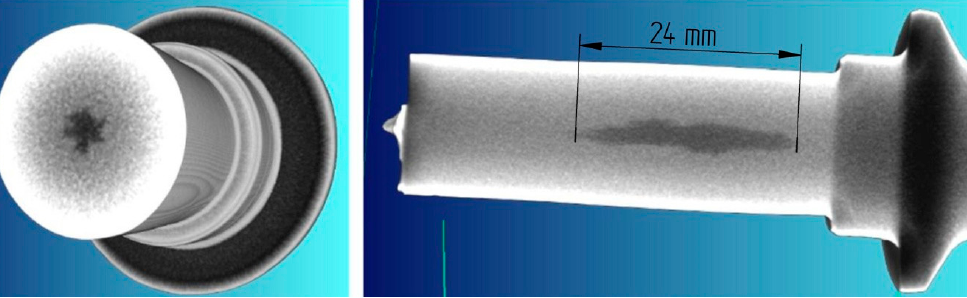
Figure 6. Results of the CT scan of the gripping part of the harrow tooth preform.